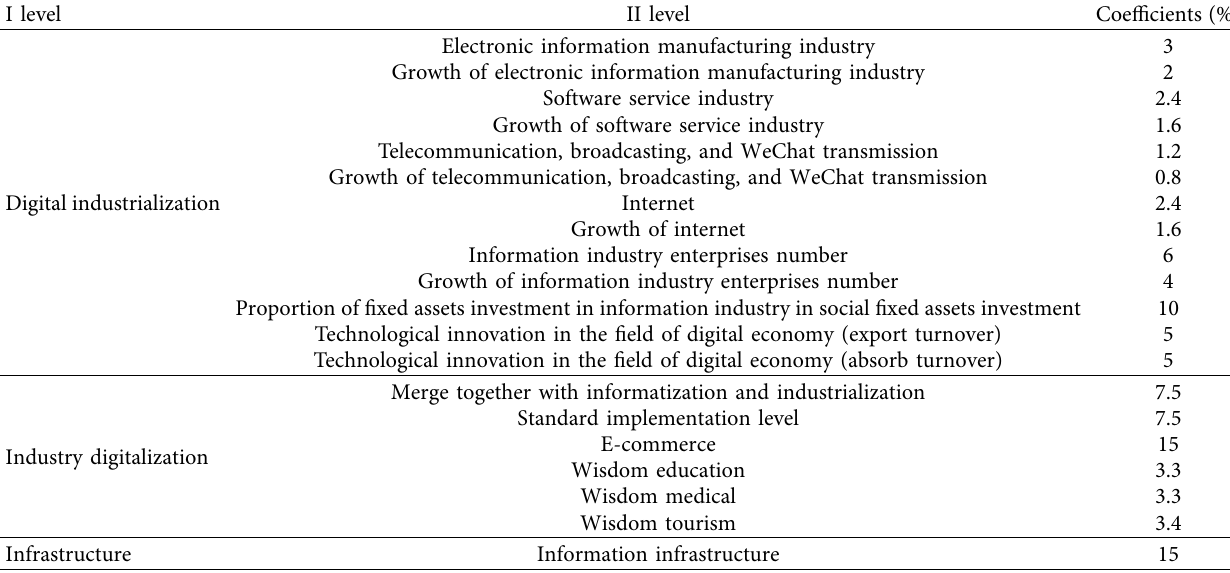
Table 1: Weights of the second